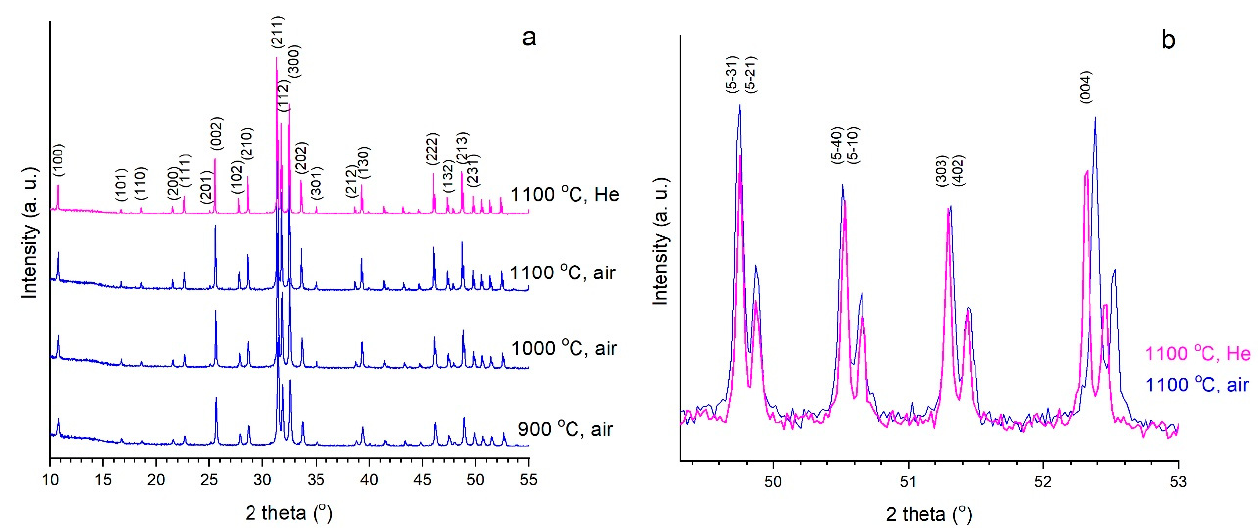
Figure 5. In situ PXRD patterns of the HA pellets heated at different temperatures in air and in helium flow; ( a )—general view, ( b )—enlarged view of the 49.4–53 ◦ 2 θ region.